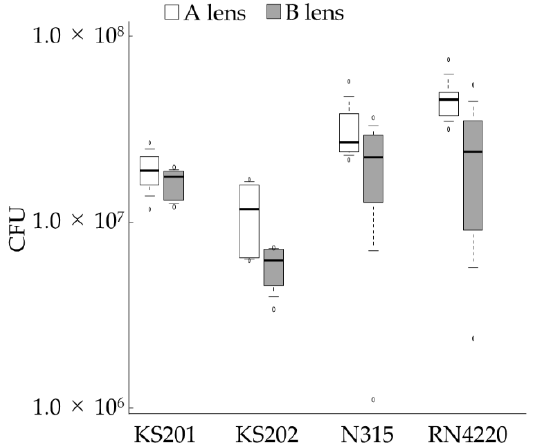
Figure 4. Number of bacteria obtained from the homogenized biofilm adhering to BCLs after 24 h of incubation. Data are presented as median (solid line), interquartile range (box), 10th–90th percentile (whiskers), and minimum and maximum (white circles). BCL, bandage contact lens; CFU, colony forming unit. The experiment was conducted once using six A and six B lenses per bacterial strain.